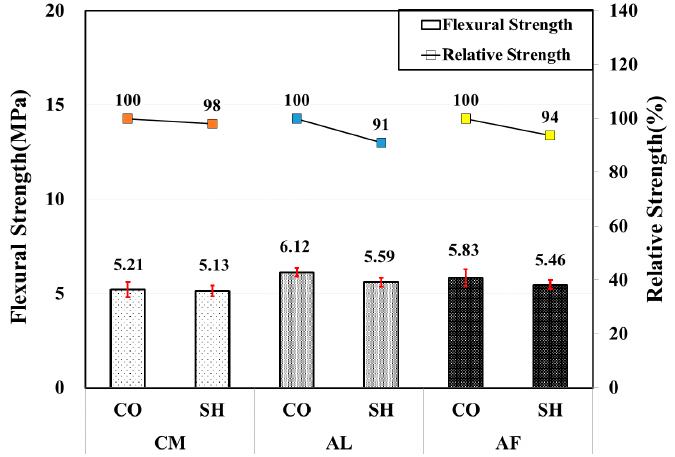
Figure 10. Flexural strength by accelerators for 6-month-old specimens.